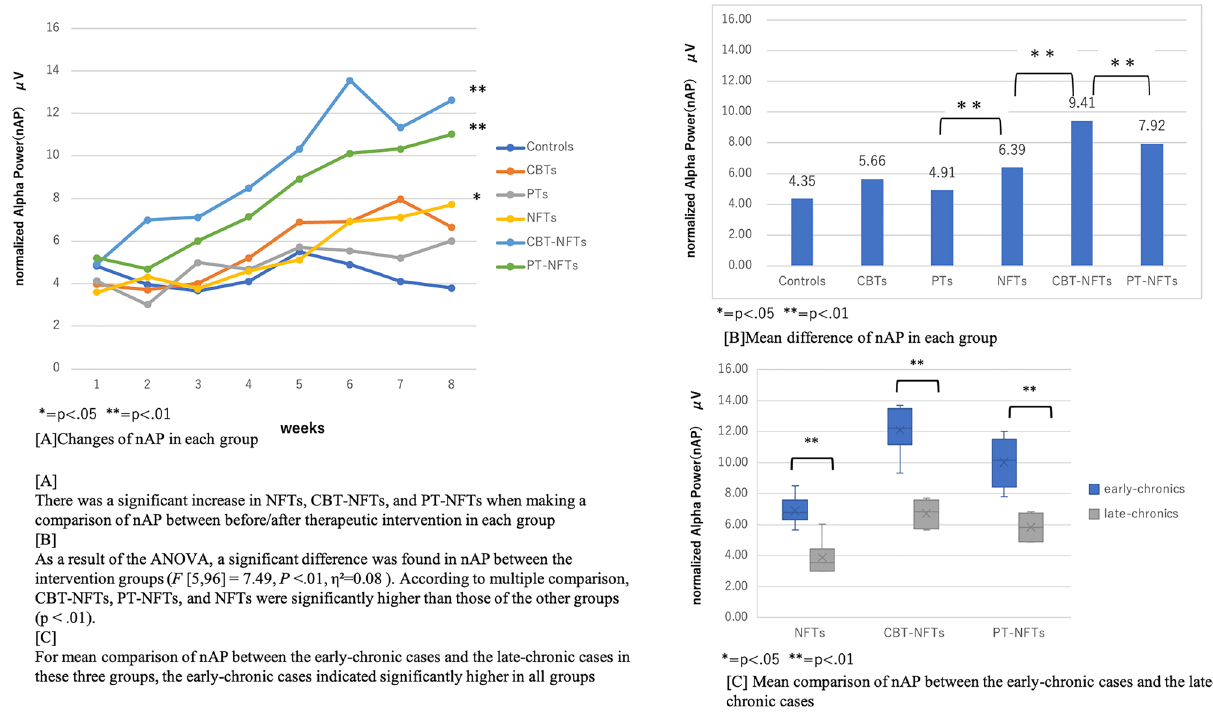
Figure 2. Mean comparison of nAP with neurofeedback training.